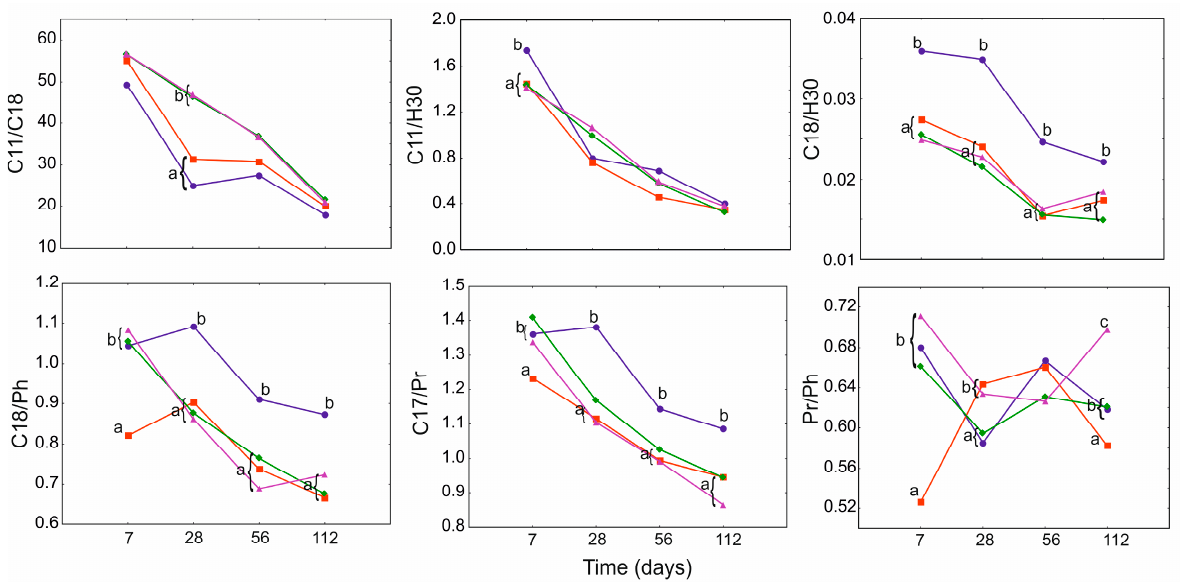
Figure 6. GLMM for geochemical ratios of lubricating oil for PGA treatment (blue and circle—PGA 0 , red and square—PGA 1 , green and diamond—PGA 1B , violet and triangle—PGA 10 ) and time (days). The different letters indicate the pairwise differences according to Duncan pairwise test. Mean values, standard error and confidence intervals are included in Supplementary Material Table S1.